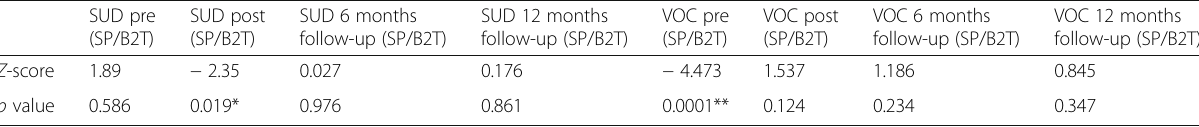
Table 4 Mann-Whitney U test SUD and VOC pre-, post- and 6 months follow-up SUD pre SUD post SUD 6 months (SP/B2T) (SP/B2T) follow-up